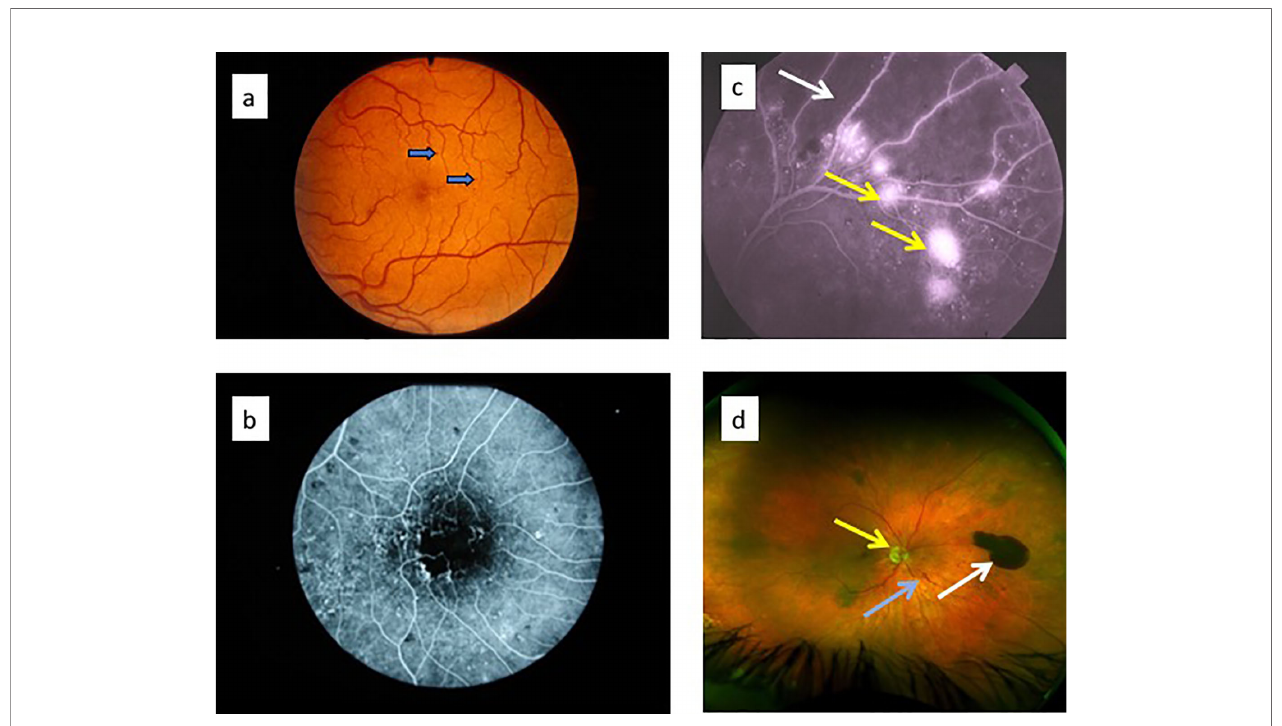
FIGURE 5 | Retinal fundus images of diabetic retinopathy. (a) fundus photograph showing microaneurysms (arrows); (b) late fl uorescein angiogram showing numerous microaneurysms (white dots) with small surrounding dark patches indicating focal retinal ischemia; (c) late fl uorescein angiogram showing abnormal capillary permeability as small areas of diffuse dye leakage from microaneurysms (yellow arrows) surrounding a large dark, non-perfused patch of retinal ischemia (white arrow); (d) ultrawide fi eld fundus image showing optic nerve head (yellow arrow), intraretinal microvascular abnormality (blue arrow) and pre-retinal haemorrhage (white arrow)